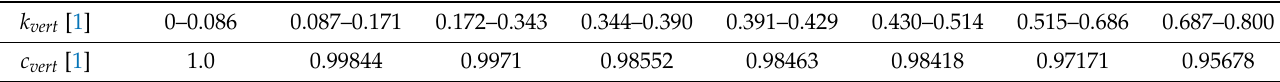
Table 2. Dependence of the coefficient c vert on the interval of distance k vert